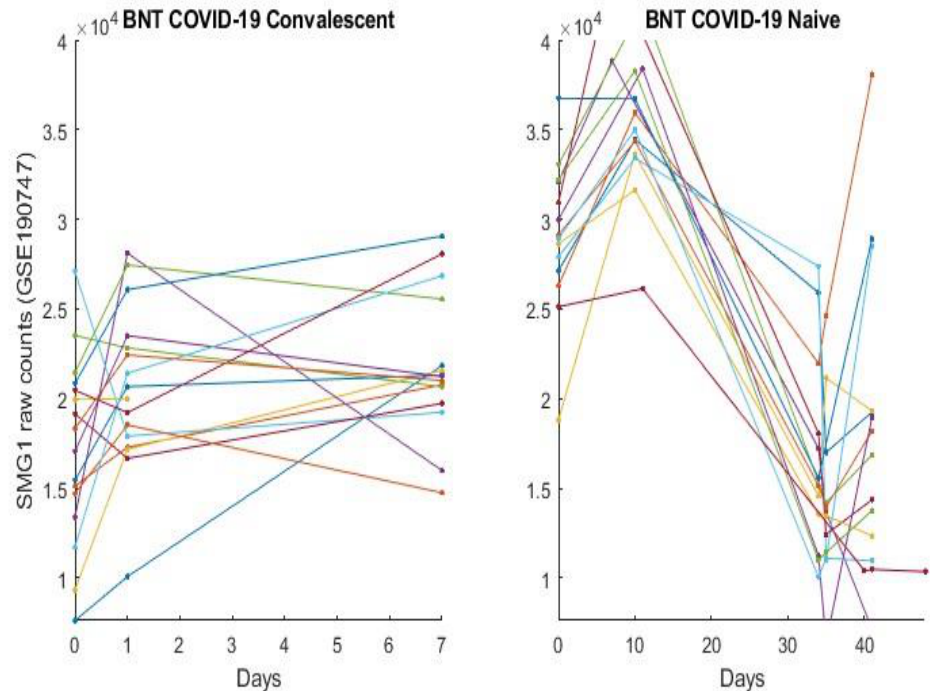
Figure 2. SMG1 expression responses to BNT162b2 vaccines: The left panel is for COVID-19-recovered octogenarians; the right panel is for COVID-19-naïve individuals. Each color line corresponds to one patient’s records.